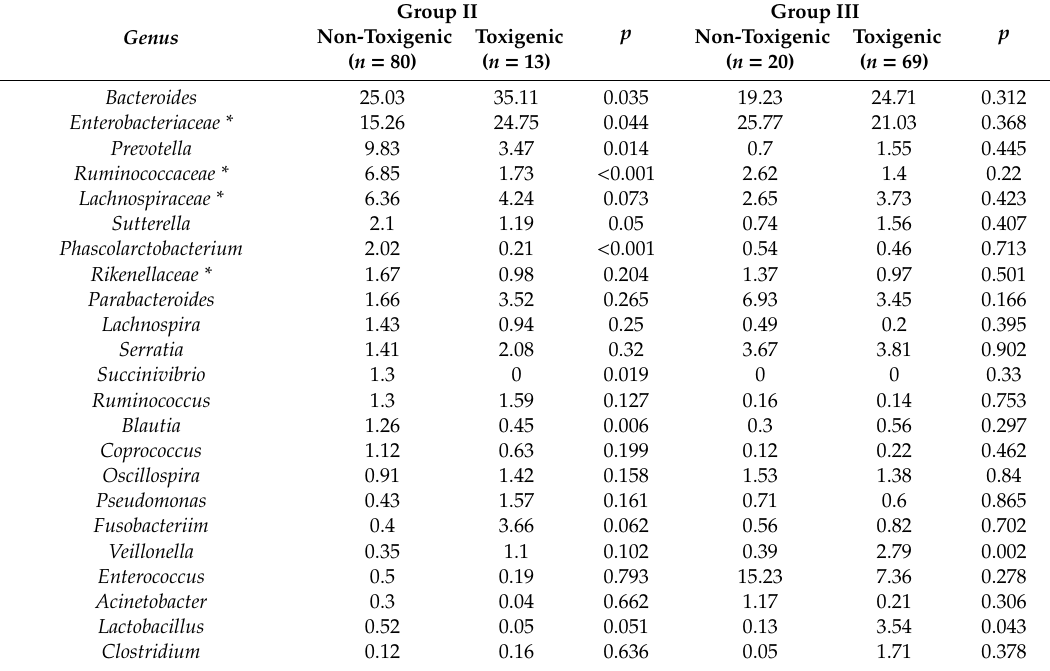
Table 5. Comparison of the mean relative abundance (%) of the composition of genera between non-toxigenic and toxigenic C. di ffi cile in groups II and